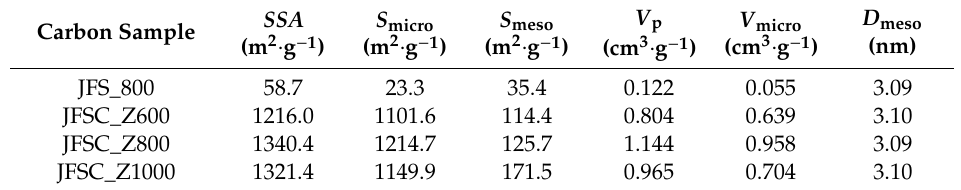
Table 1. Surface textural properties of nanoporous activated carbons obtained from Jackfruit seed. Carbon